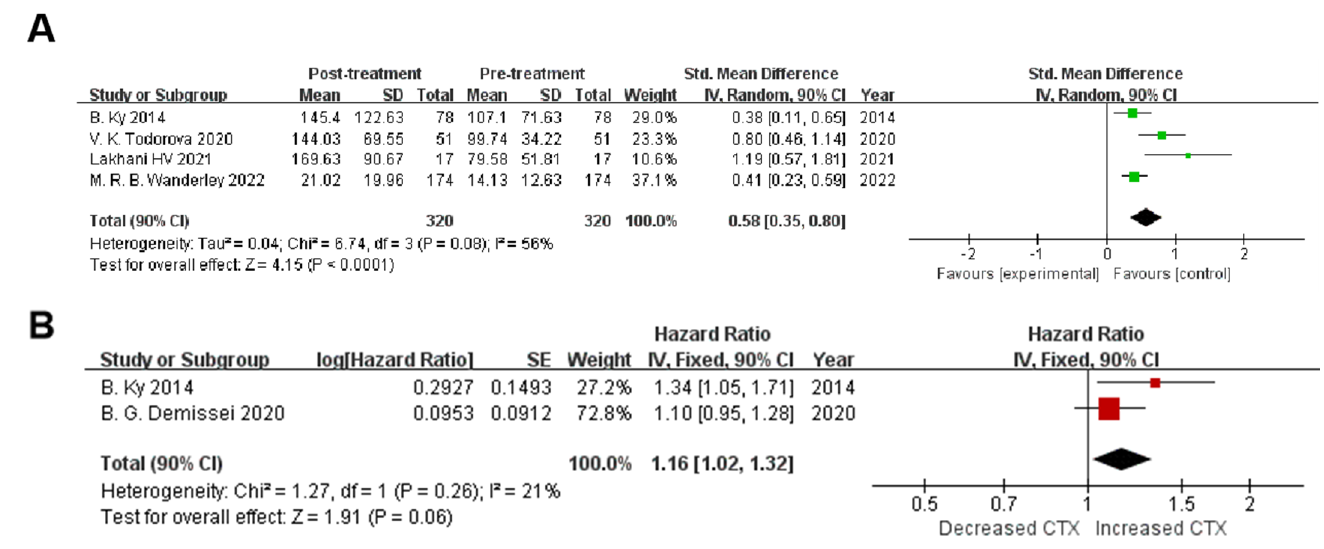
Figure 5. ( A ) Overall and individual study estimates of the standardized mean difference of MPO are shown in patients receiving cancer treatment. Parallelogram boxes for standardized mean difference, and horizontal lines represent 90% confidence interval (CI). ( B ) Cancer-therapy-related cardiotoxicity as measured by a standardized left ventricular ejection fraction decrease with significant MPO change. Parallelogram boxes for hazard ratio, and horizontal lines represent 90% confidence interval (CI)